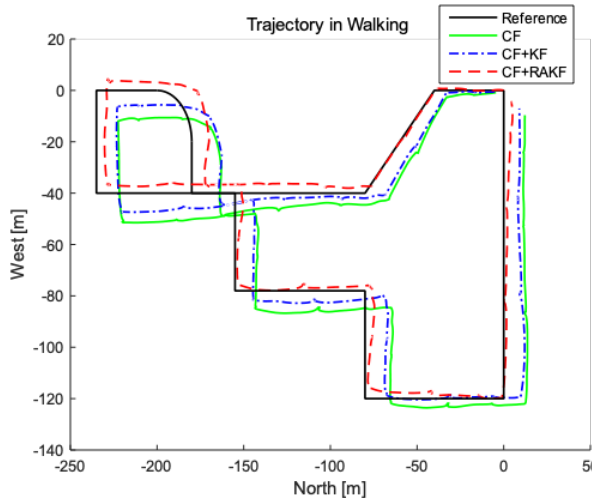
Figure 10. Comparison of trajectory in walking under different heading estimation algorithms performed in second floor of entire Internet of Things (IOT) Engineering College.